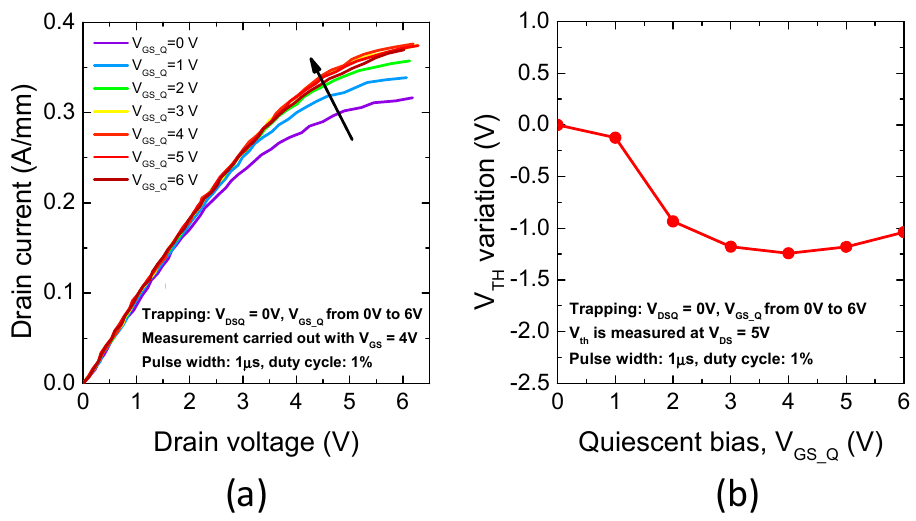
Figure 7. ( a ) Pulsed I D -V DS curves measured starting from several quiescent bias points on a GaN HEMT with p-GaN gate; ( b ) Variation of threshold voltage as a function of the quiescent bias point V GS_Q applied to the gate (Courtesy of Isabella Rossetto, University of Padova).